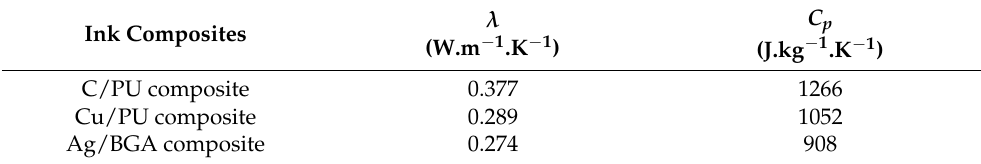
Table 6. Thermal properties of the composite inks based on mixing laws. Ink